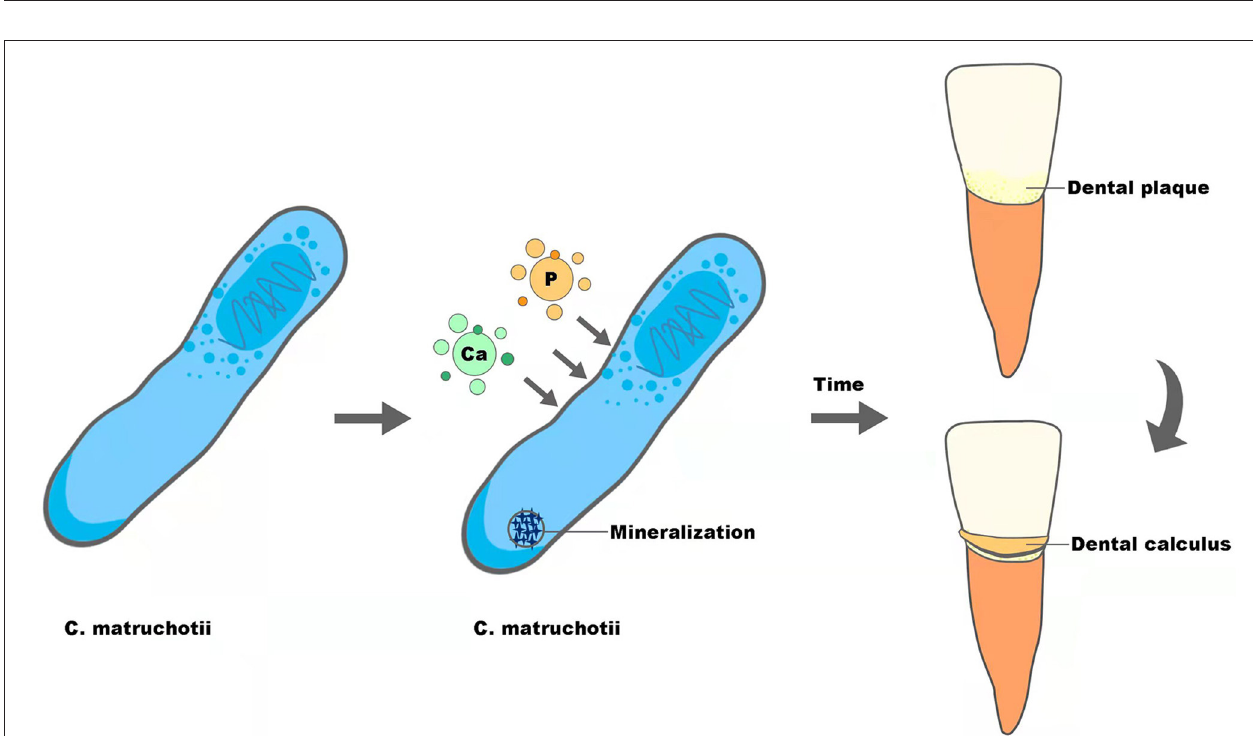
FIGURE 1 | The structure alteration of supragingival plaque from healthy oral status to dental caries.